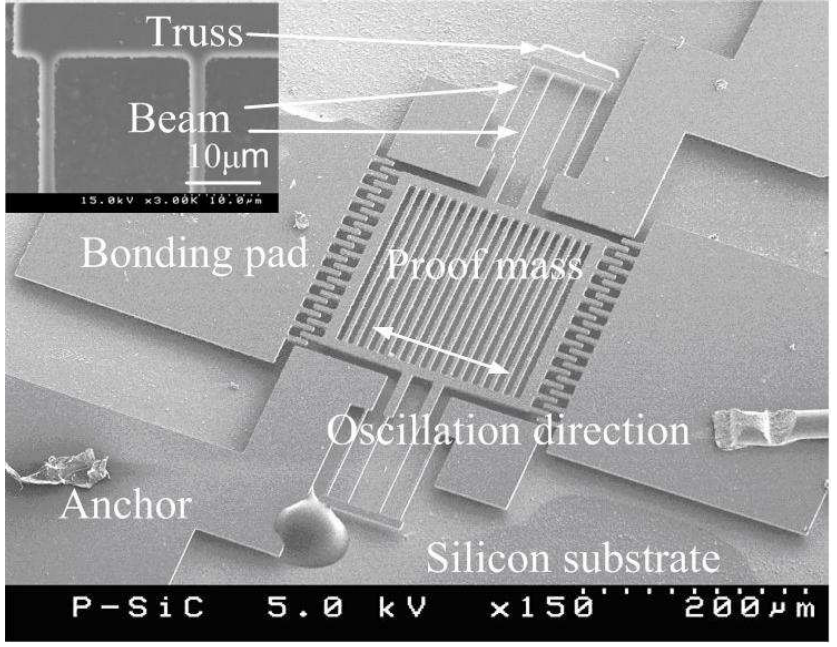
Figure 2. Schematic cross-section of the 3C-SiC lateral resonators used in this